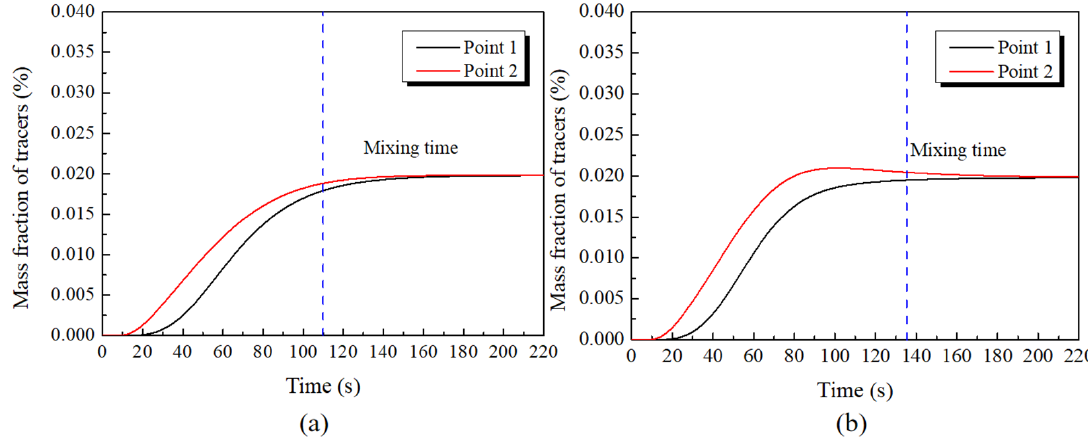
Figure 9. Comparison of mixing time during ladle refining: ( a ) S–P mode, ( b ) P–P mode.